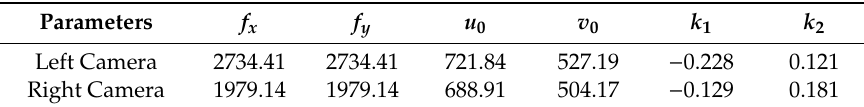
Table 1. Intrinsic parameters of the left and right cameras.